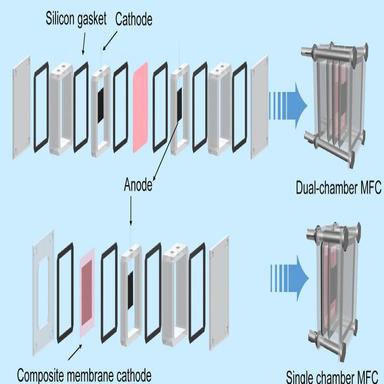
Scheme illustrates the MFC configuration used in this study.